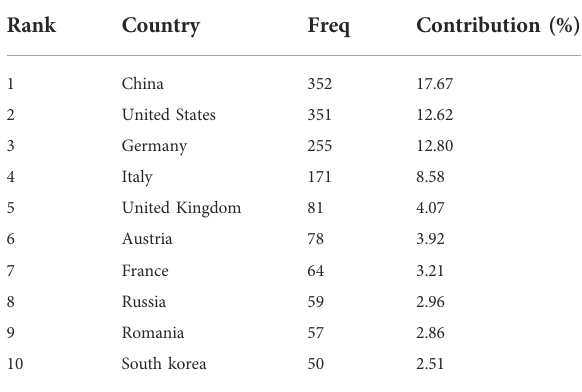
TABLE 1 Top 10 countries with the highest productivity of publications related to applications of TPP in biomedical fi eld. Rank